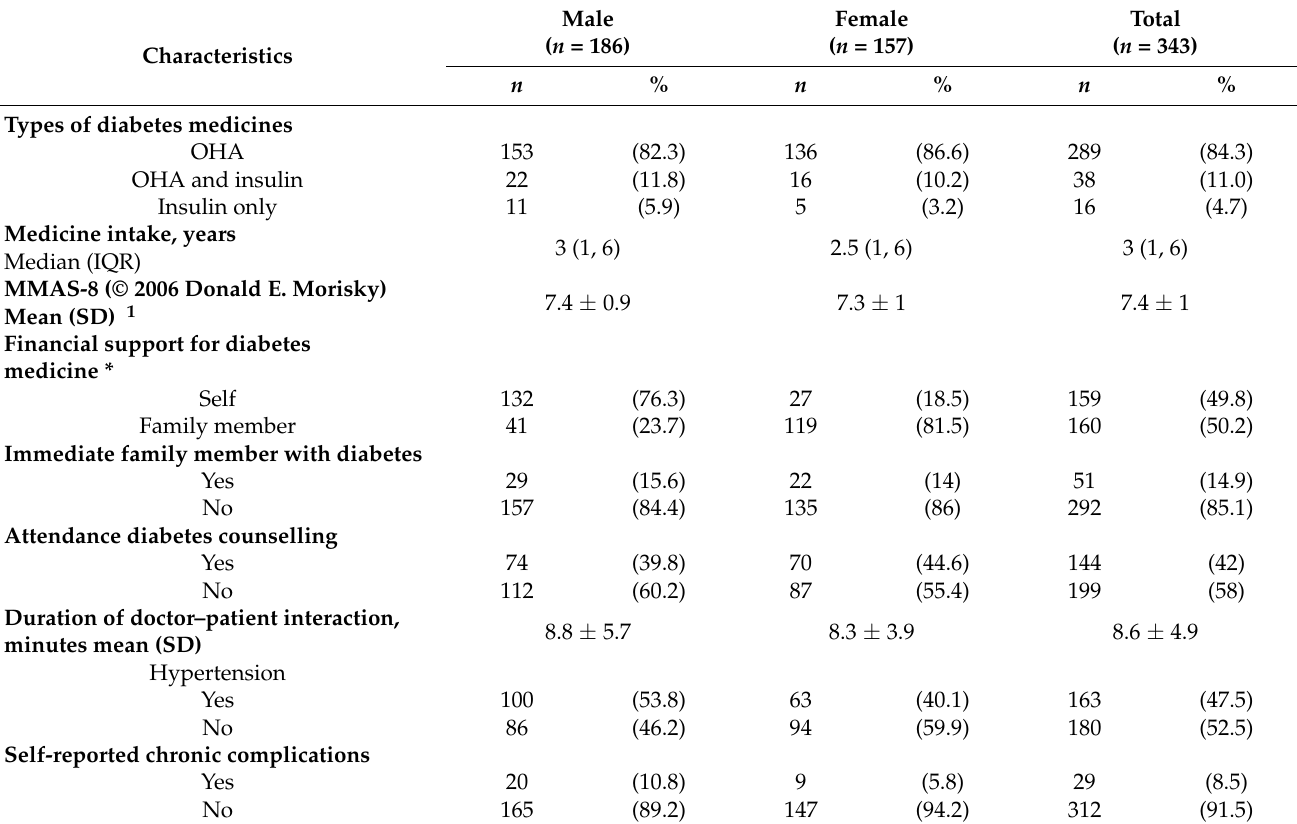
Table 2. Clinical Characteristics among 343 diabetes patients at Dhulikhel